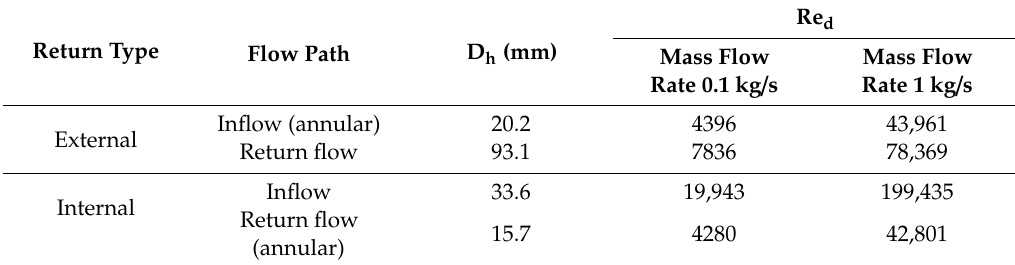
Table 5. Representative value of flow parameters for each case.